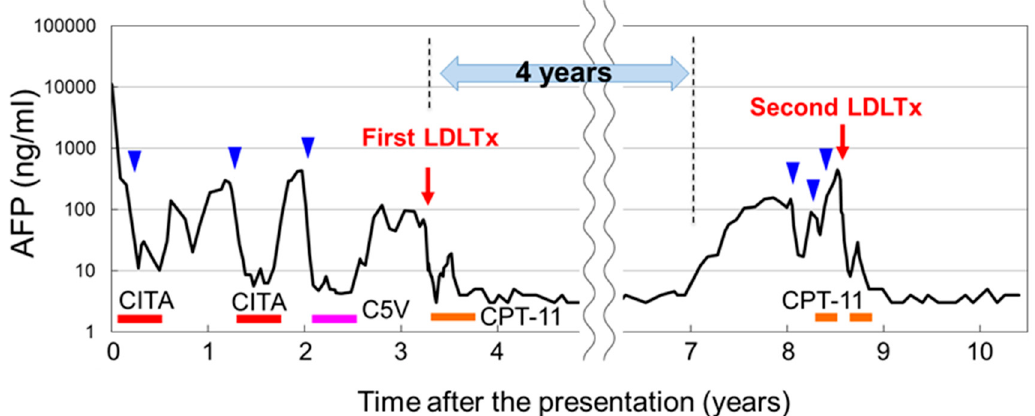
Figure 1. The clinical course of the patient. The years after the initial presentation are plotted on the horizontal axis, and the values of alpha-fetoprotein (AFP) are plotted on the vertical axis. Blue arrowheads indicate laparotomies other than living donor liver transplantation (LDLTx). Bars on the bottom represent the chemotherapeutic regimen. CITA: cisplatin 80 mg / m 2 and tetrahydropyranyl adriamycin (THP-ADR) 30 mg / m 2 , C5V: cisplatin 90 mg / m 2 , 5-fluorouracil 600 mg / m 2 and vincristine 1.5 mg / m 2 , CPT-11: Irinotecan 20 mg / m 2 .